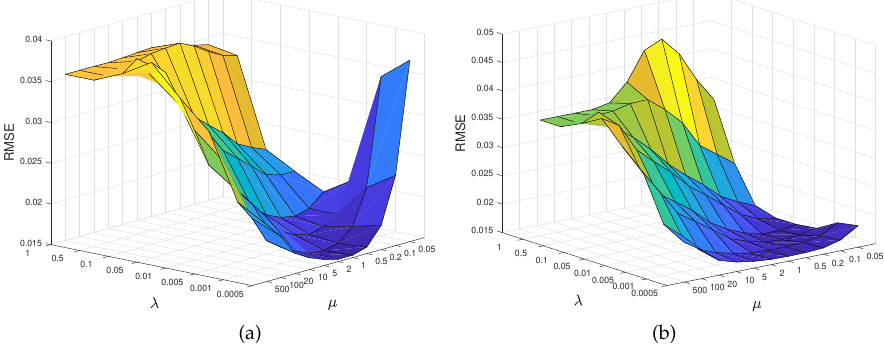
Figure 2. RMSE as a function of the regularization parameters for the proposed method with S 1 using Gaussian kernel.